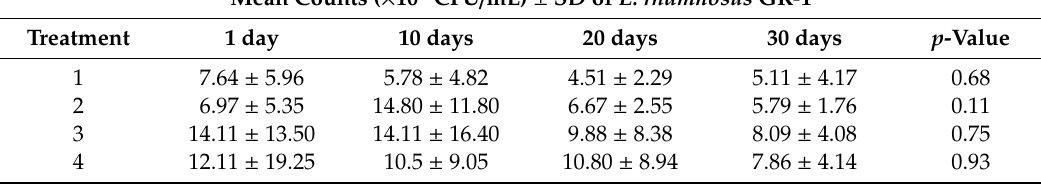
Table 2. Viable counts (Mean ± SD) of Lactobacillus rhamnosus GR-1 in probiotic yogurt treatments following 1, 10, 20, and 30 days of refrigerated storage.